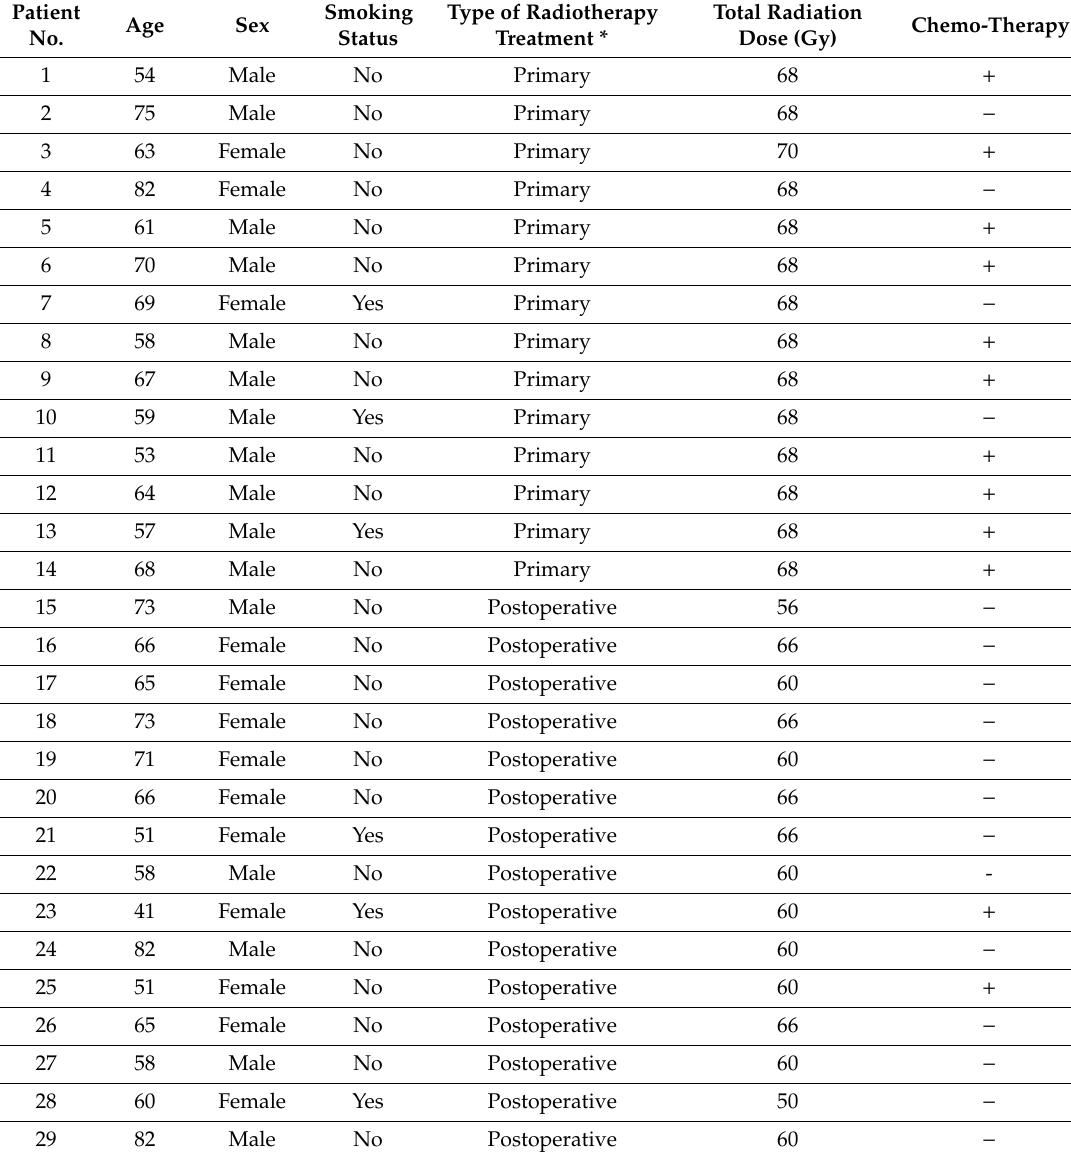
Table 1. Clinical characteristics of patients included in the